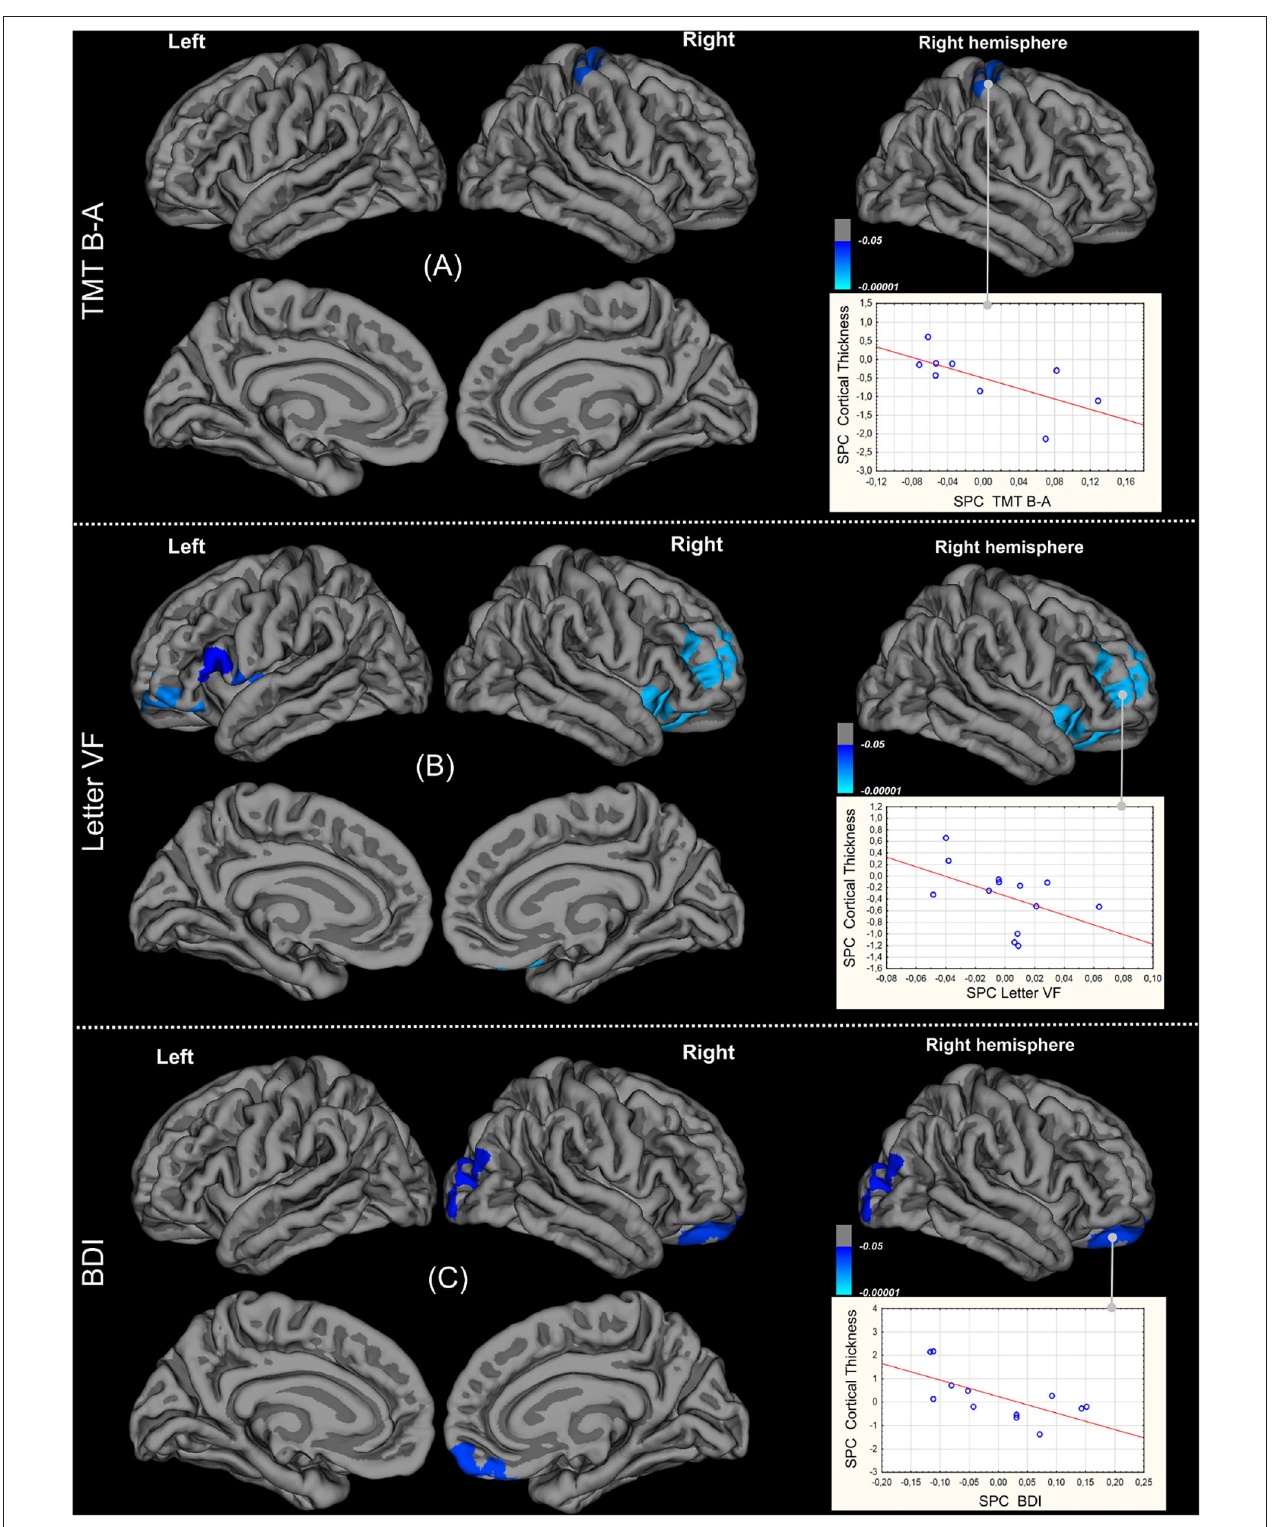
FIGURE 4 | Correlations between changes of Cortical Thickness and those of abnormal clinical scores: TMT B-A (A) , letter-fluency index (B) , Beck Depression Inventory (C) .